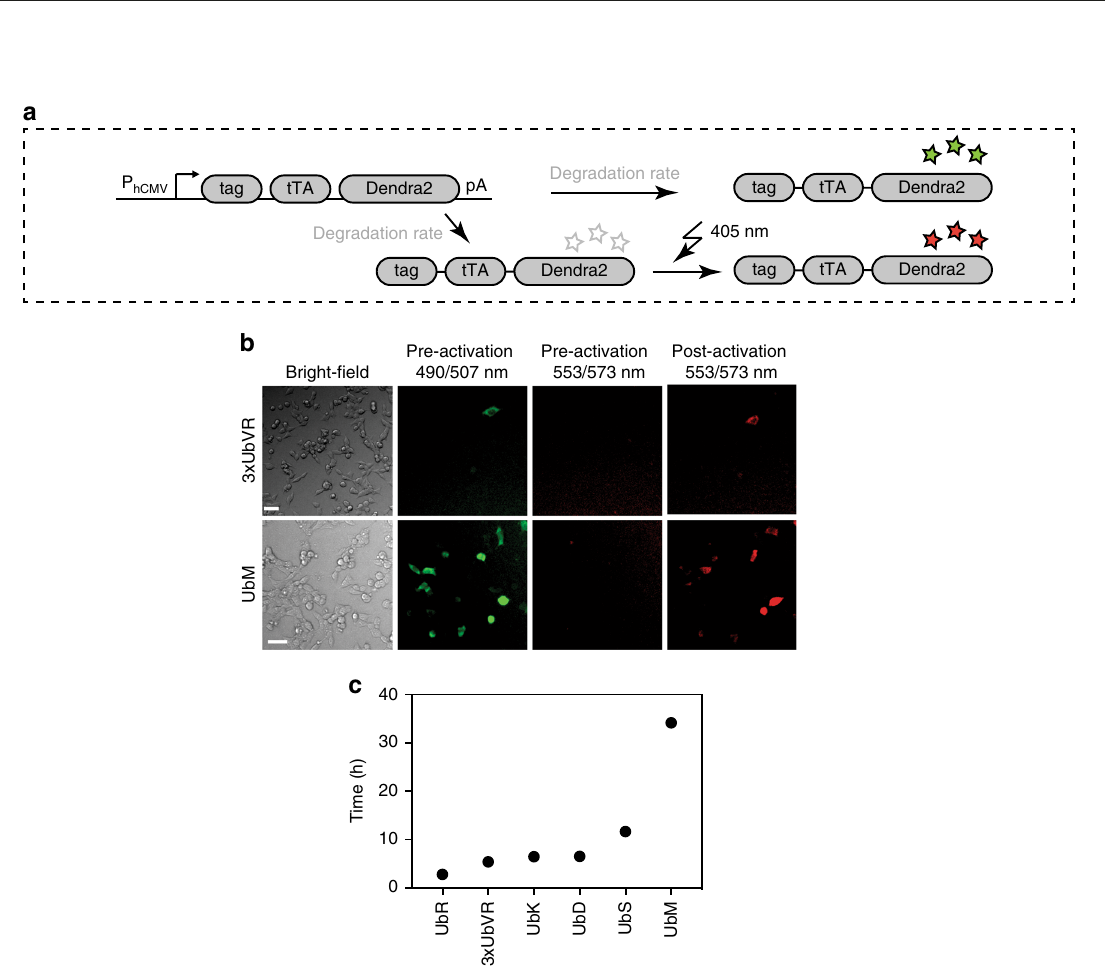
Fig. 3 Determination of the protein half-lives of the six selected constructs. a Before photoconversion, the chromophore of Dendra2 exists in an equilibrium between neutral (non fl uorescent) and anionic (green fl uorescent) states. Excitation of the neutral chromophore with light at 405 nm results in photoconversion to a red fl uorescent state. b Fluorescence microscopy images of cells transfected with P hCMV -3x UbVR - tTA - Dendra2 -pA and P hCMV - UbM - tTA - Dendra2 -pA before and after photoconversion with 405 nm light. The image intensities were all stretched by the same factor, while maintaining the same intensity ratio for better visibility. White scale bars correspond to 50 µ m. c HEK-293 cells (3 × 10 4 ) were transfected with the six selected tags (3xUbVR, UbR, UbK, UbD, UbS, UbM) and the half-lives of the constructs were determined by time-lapse microscopy. Photoconversion was conducted after 24 h with blue light and fl uorescence images were recorded every 10 min. The data represent the mean ( n = 3 independent experiments) measured in triplicate. Source data for this fi gure is available in the Source data fi